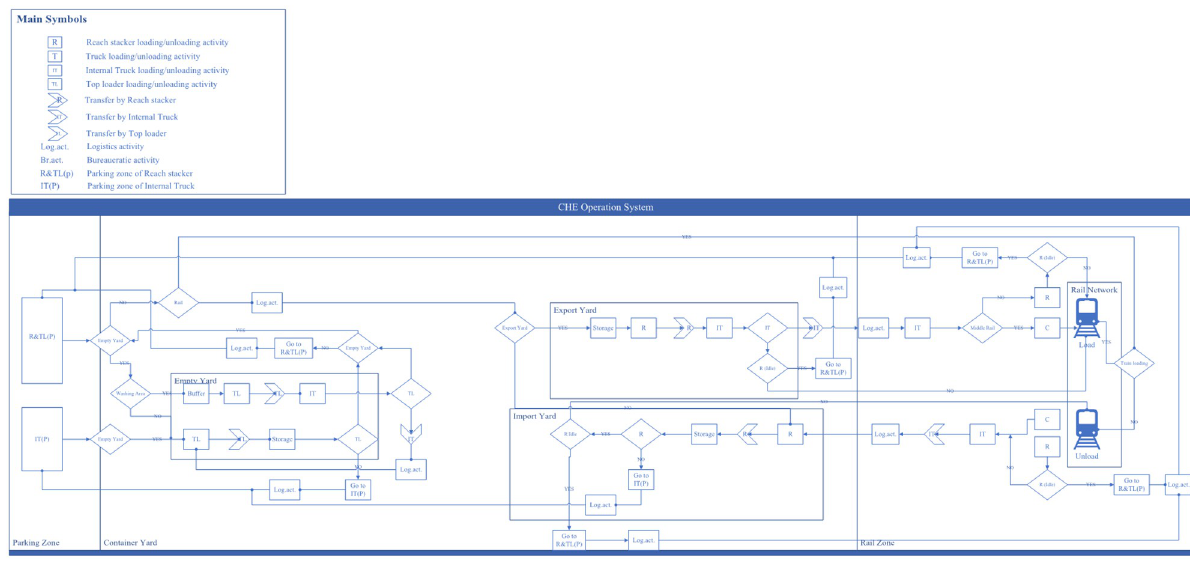
Fig 6. Operational flow of the CHE operation